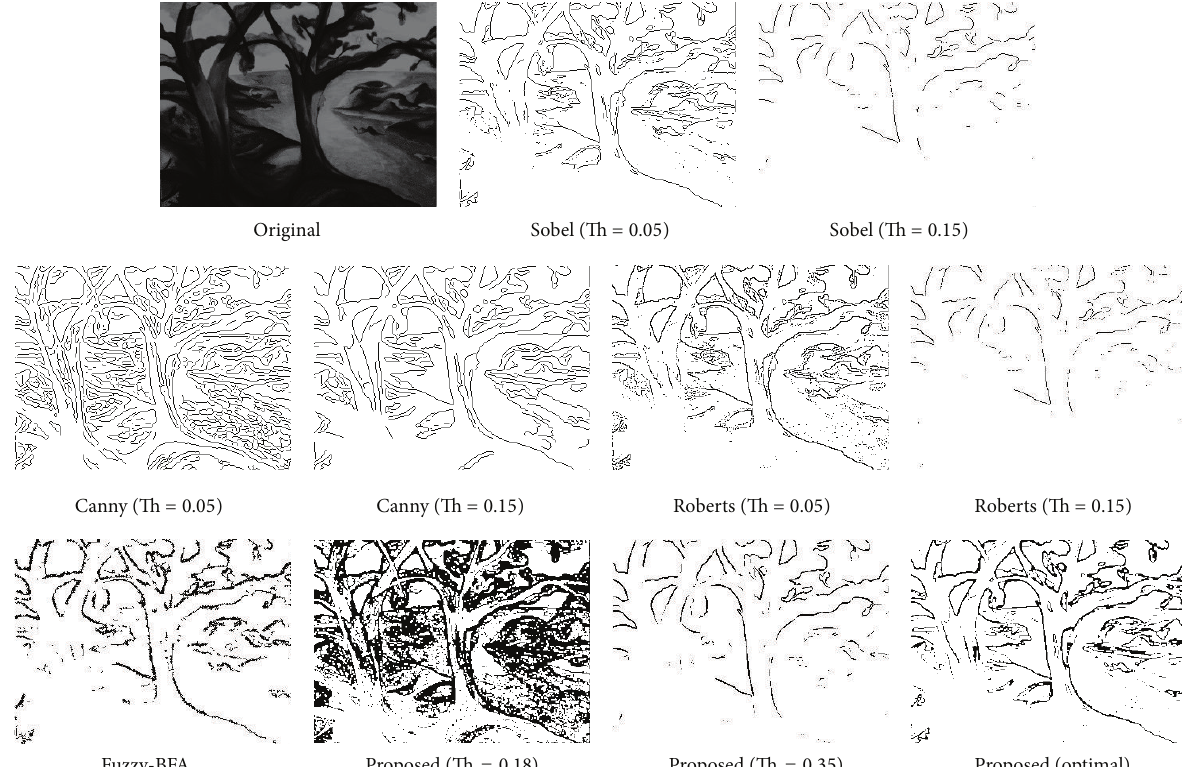
Figure 13: Edge detection results of “trees” image: Sobel, Canny’s, and Roberts methods using thresholds = 0.05 and 0.15; fuzzy-BFA method; proposed method with fixed thresholds (0.18 and 0.35) and optimal threshold.